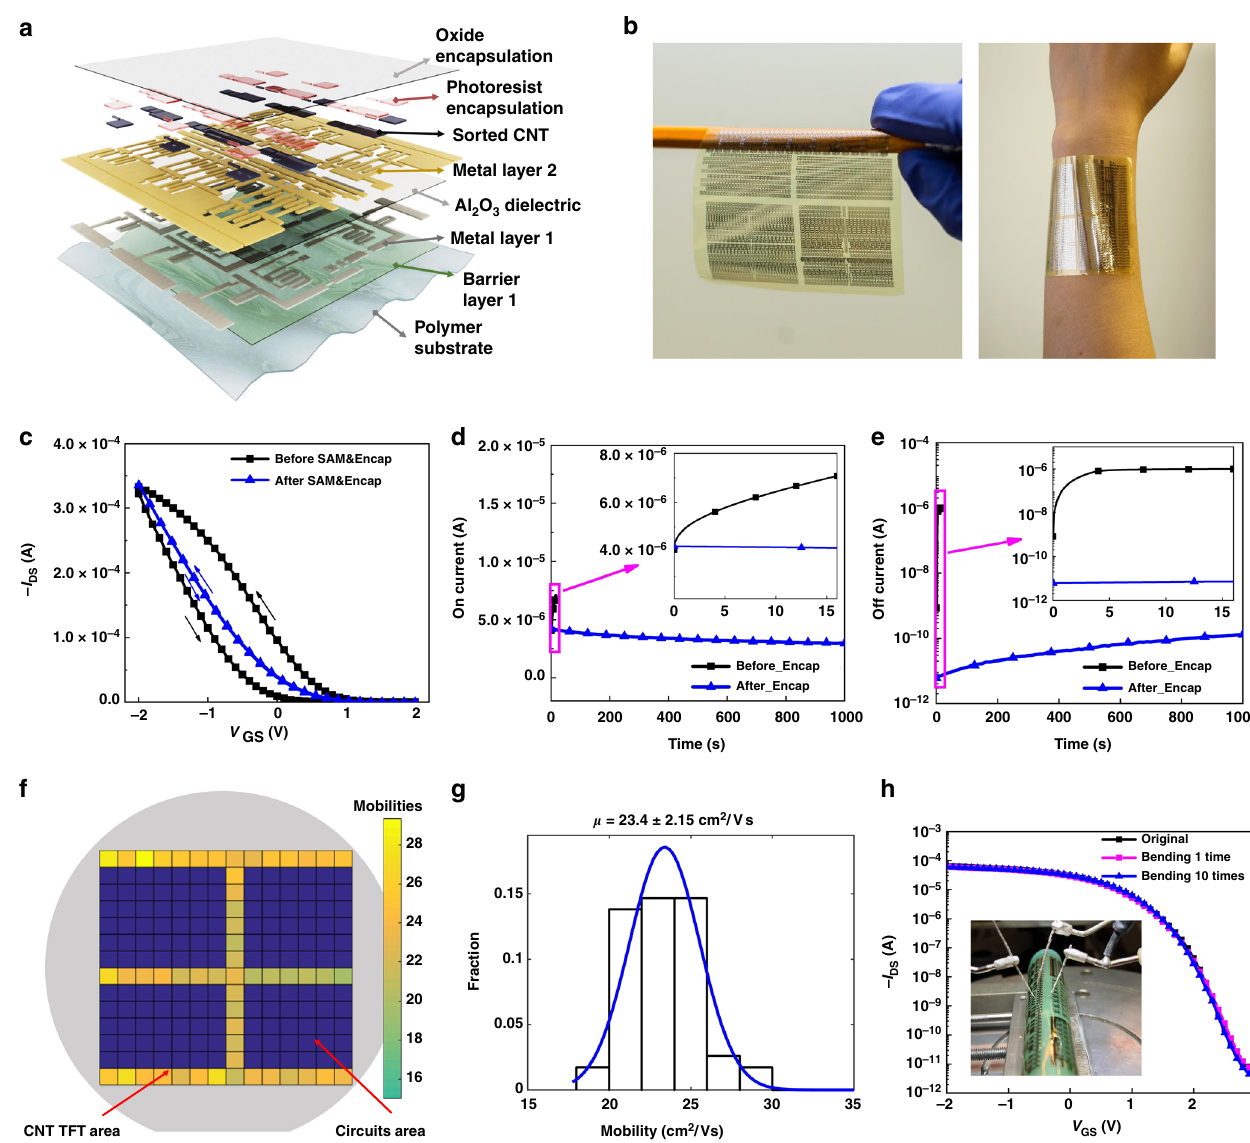
Fig. 2 Device layer structures and electrical characterizations of CNT TFTs on a plastic substrate. a Layer structures of the CNT TFT device. b Photos of CNT TFT devices fabricated on a 10- μ m fl exible polyimide substrate. The thin fl exible devices show good conformal attachment to human skin. c Transfer characterizations of CNT TFTs before and after SAM layer modi fi cation and Al 2 O 3 encapsulation ( V DS = − 1 V). d On-current bias stability of a CNT TFT before and after Al 2 O 3 encapsulation. Inset shows the enlarged area (0 – 16 s) of the bias stability test. e Off-current bias stability of a CNT TFT before and after Al 2 O 3 encapsulation. Inset shows the enlarged area (0 – 16 s). f , g Mobility statistics from 56 CNT TFTs tested on a 4-inch wafer. The 56 CNT TFTs are distributed on the yellow areas. The colored scale bar indicates the mobility values. Dark blue areas are circuit areas and were not tested. The average mobility of CNT TFTs is 23.4 cm 2 V − 1 s − 1 with a standard deviation of 2.15 cm 2 V -1 s -1 . h Bending test of a fl exible TFT with a bending radius of 5 mm. Only slight current changes (<10%) were observed after 10 times of repeated bending. Inset shows the bending and testing setup